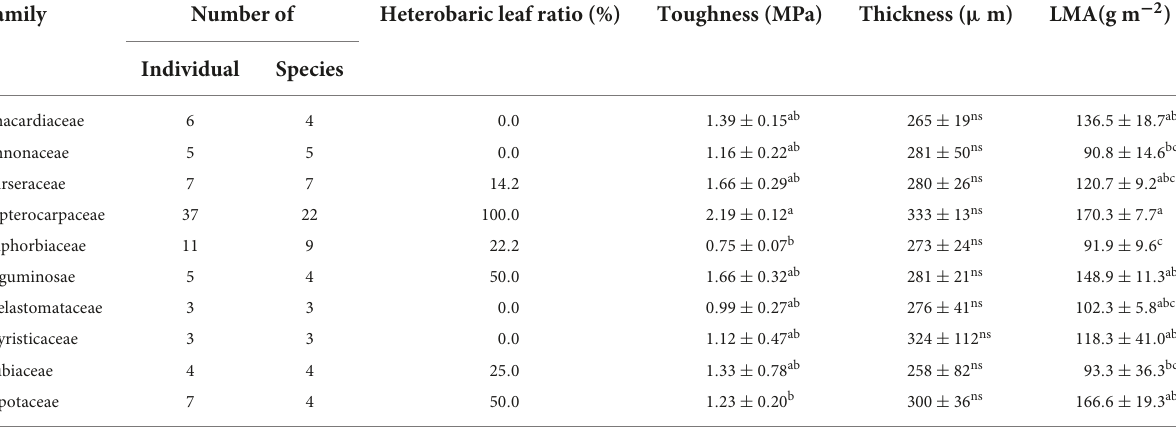
TABLE 4 The numbers of individuals and species, proportion of heterobaric species, leaf toughness, thickness, and LMA among 10 families. Family